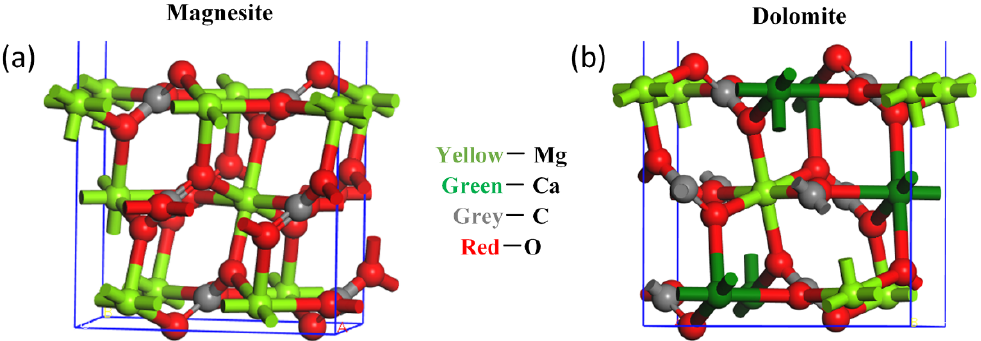
Figure 10. Structure diagram of common crystal cleavage planes of ( a ) magnesite and ( b ) dolomite. Table 2. Metal site properties of (104) planes of magnesite and dolomite. Minerals Metal site Density/nm 2 Number of Broken Bonds at Metal Site Magnesite (104) Mg:5.70 2 Dolomite (104) Ca: 2.704; Mg: 2.704 2